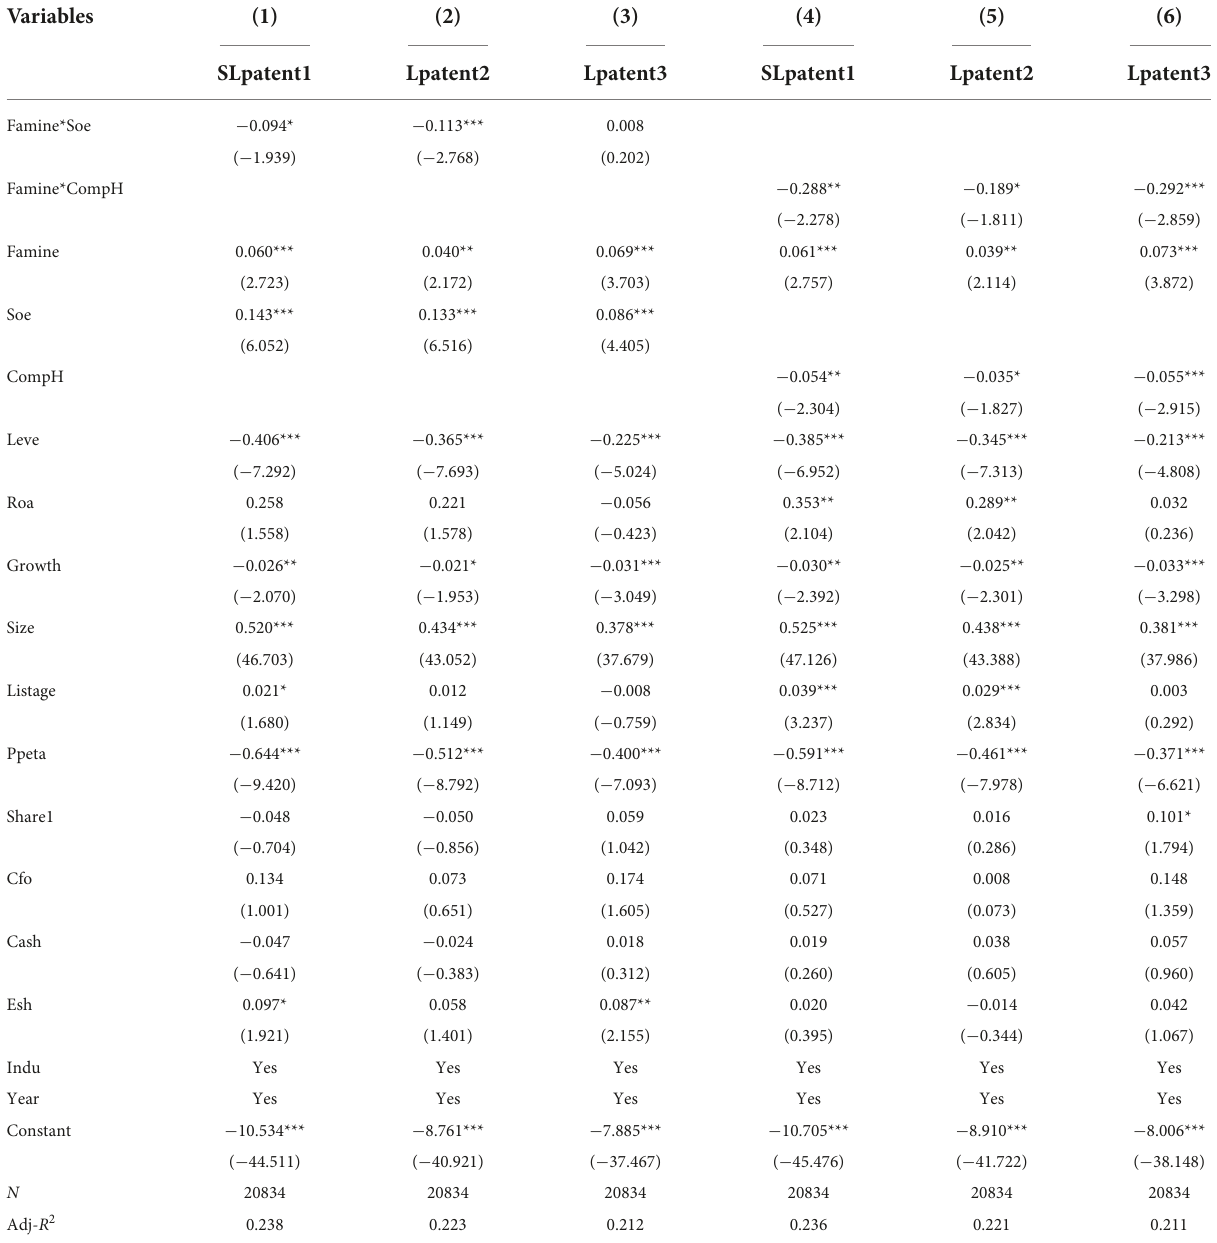
TABLE 6 Regression results of the moderating effects of the nature of property rights and market